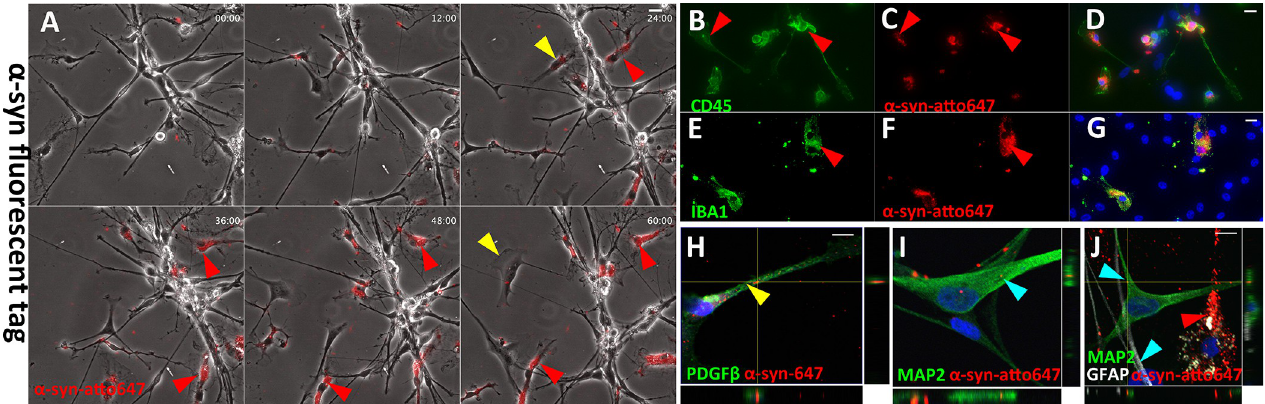
Fig 6. Primary human mixed neuronal cell exposed to α -syn aggregates—internalisation is cell type-specific. (A) Representative images of live cell recording with α -syn-594 aggregates. (B-C) Confocal imaging indicates that α -syn-594 aggregates are present within neurons and pericytes. (E-I) Cells with high α -syn aggregate load are microglia CD45 + and IBA1 + . Representative images of primary human mixed neuronal cell exposed to (J) Ribbons with (L-O) Ribbons within Astrocytes GFAP high, MAP2 low and (P-S) neurons GFAP low-MAP2